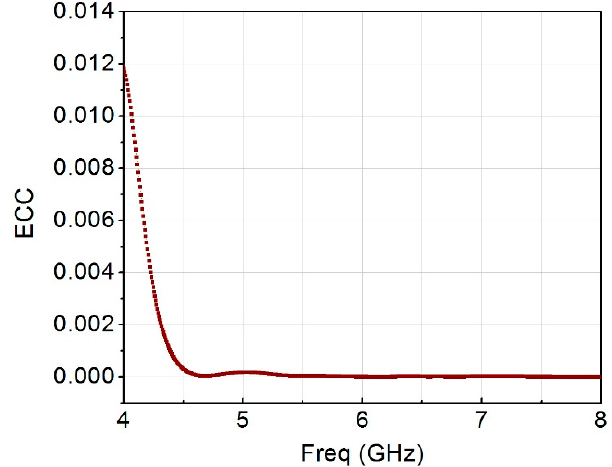
Figure 19. Envelope correlation coefficient of the MIMO antenna.